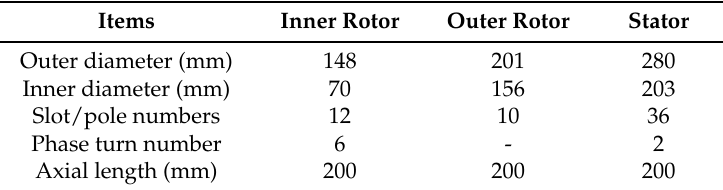
Table 3. Size parameters of the DMP